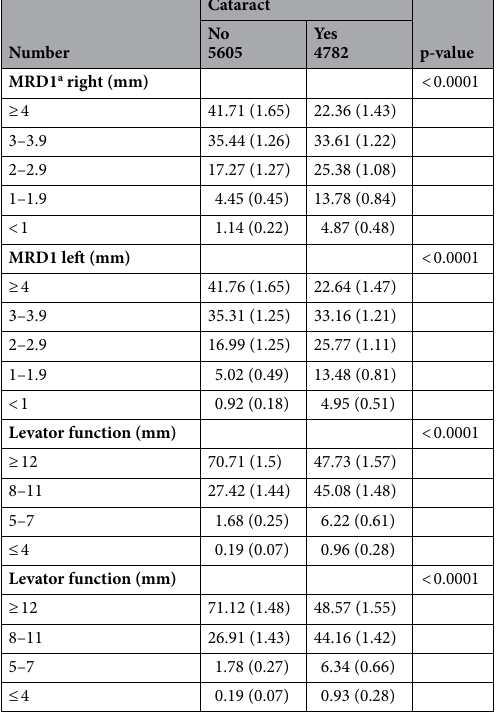
Table 2. Cataract prevalence according to MRD1 and levetor function level. a Marginal reflex distance 1 (MRD 1) was measured from the central upper lid margin to the pupillary light reflex on the cornea.